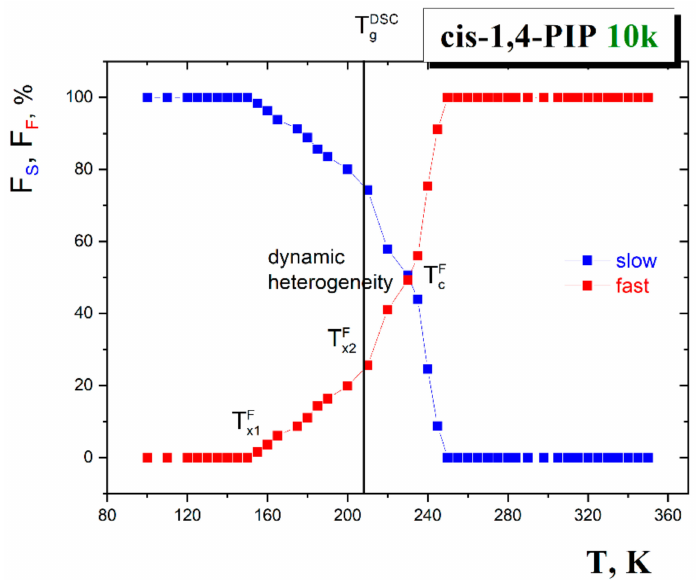
Figure 4. Fractions of the slow and fast reorienting spin probe TEMPO in cis -1,4-PIP10k as a function of temperature [40]. The crossover effects T X1F , T X2F and T cF are in agreement with the characteristic ESR temperatures of the correlation time T X1slow , T X,infast ~155 K and T c ~250 K in Figure 3. The glass- to-liquid transition T gDSC is depicted by the vertical line.